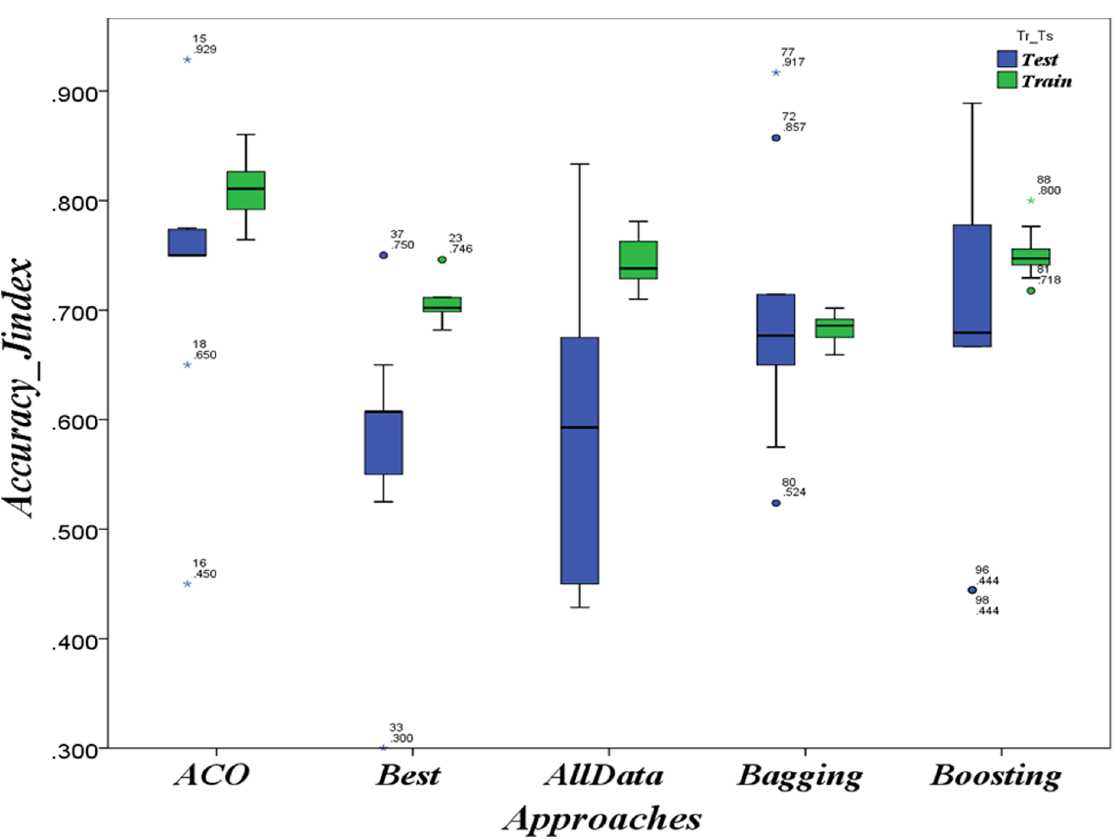
Figure 3. Evaluation in HD case: Prediction accuracies in the context of Hungarian population C Hungarian ACO-based approach Vs. Best model, data-combination Model, Boosting and Bagging.